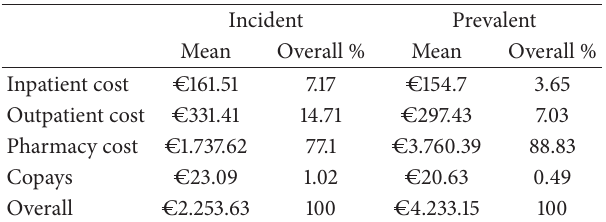
Table 2: Annual costofincident and prevalent ankylosing spondyli- tis patients in